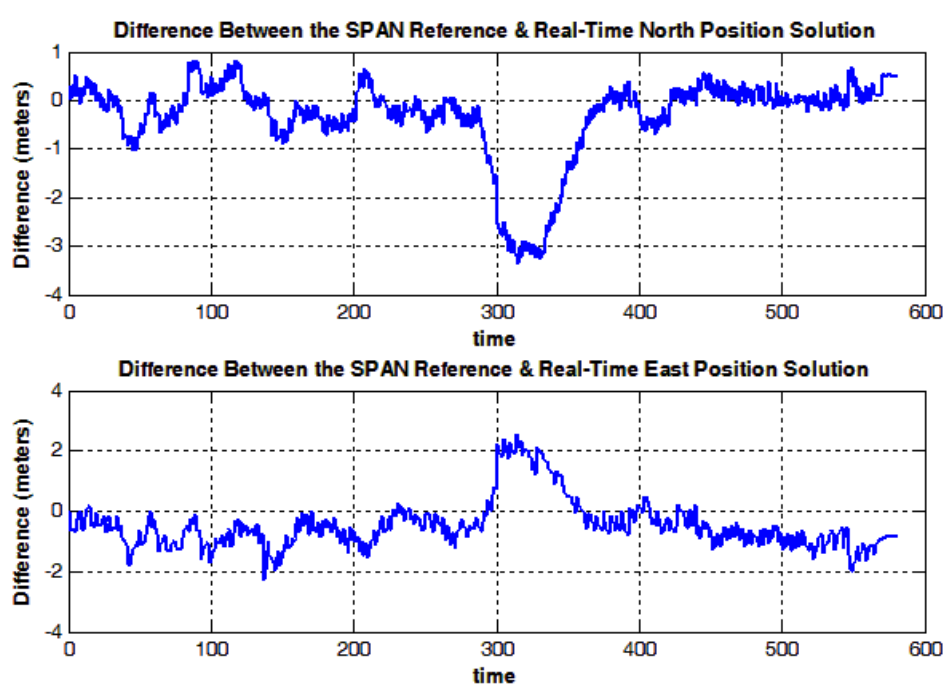
Figure 15. Mobile Robot Trajectory (1): Difference between NovAtel SPAN Reference and MicroBlaze Real Time